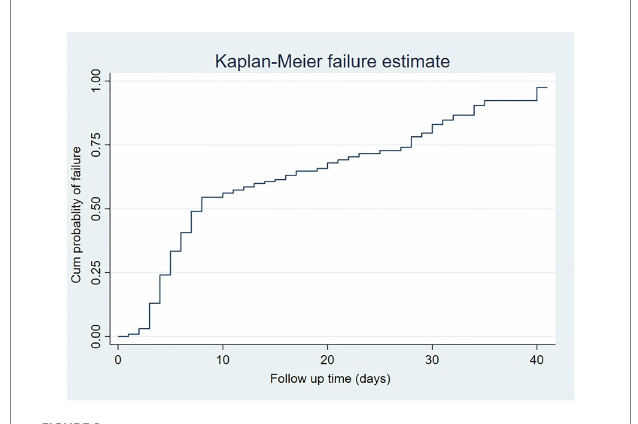
FIGURE 2 A Kaplan–Meir failure estimate of surgical patients admitted to ICU from February 2017 to February